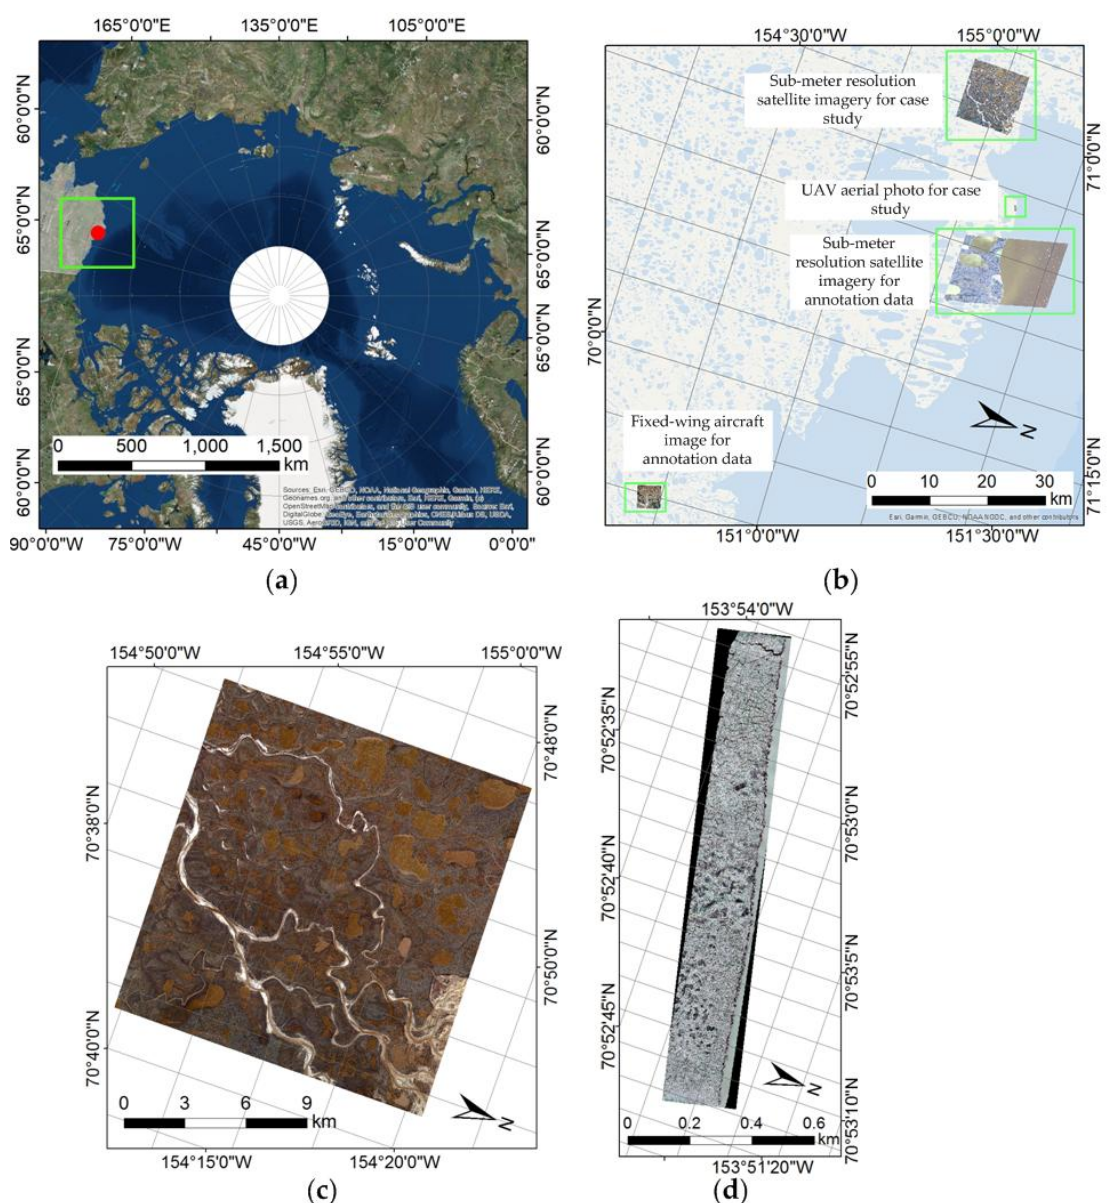
Figure 1. Both target images are located near Drew Point, Alaska (see red dot) ( a ). Locations of all images used in this study (see green boxes) are presented in ( b ). The images used in the case studies included ( c ) the fused WorldView-2 (Imagery © [2015] DigitalGlobe, Inc.), and ( d ) the UAV images. Table 1. Description of used datasets.